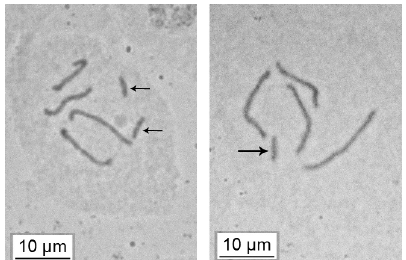
Figure 2. Embryonic cells of Jansenus burgeri Foldi, 1997 in female (2n=6) and male (2n=5) embryos; sex chromosomes are arrowed.